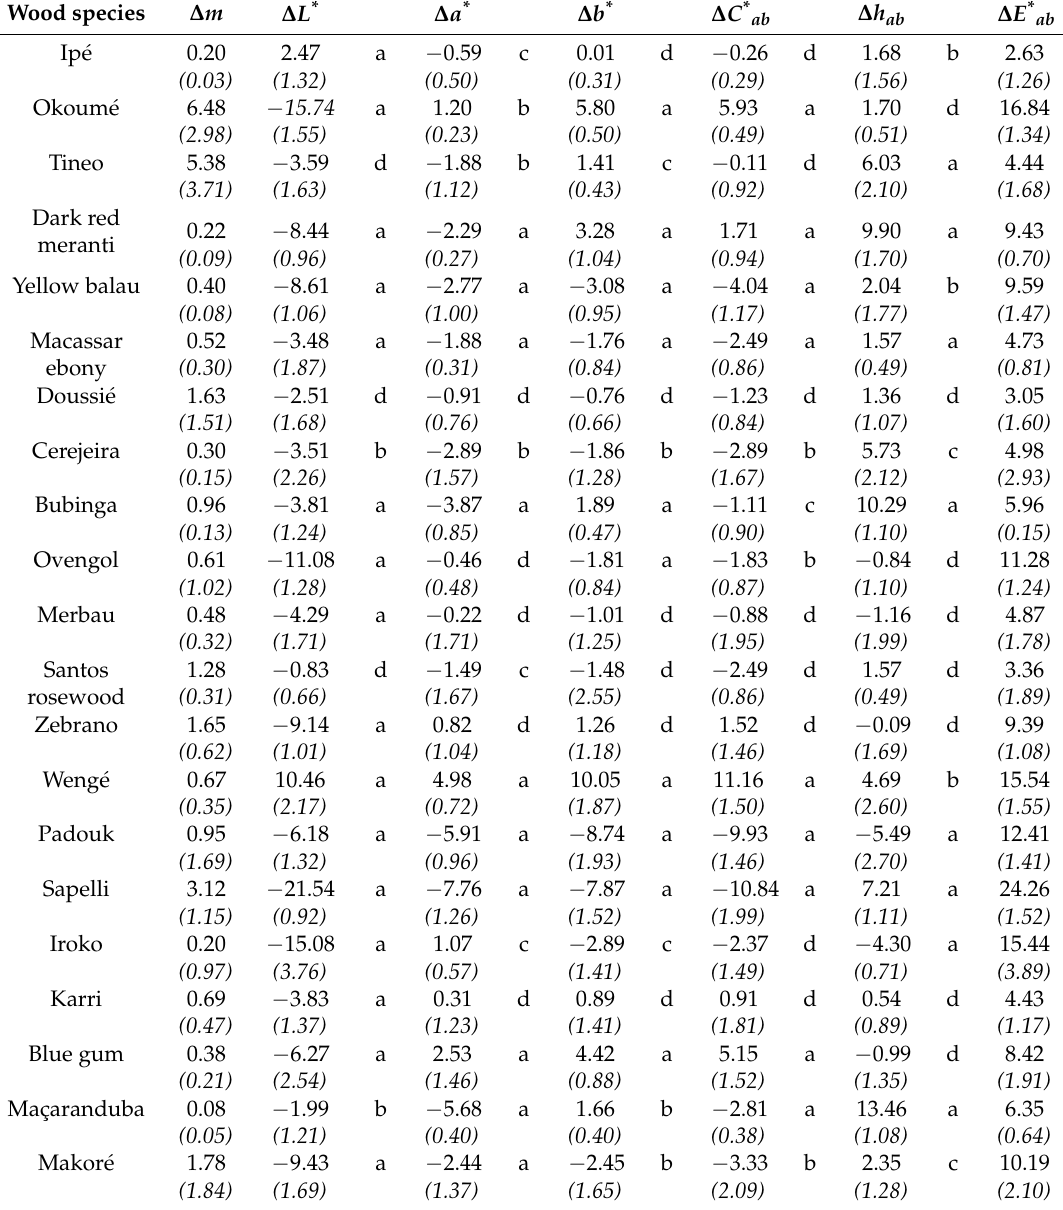
Table 3. Weight loss and relative change of colourimetric parameters of 21 tropical woods caused by C. puteana